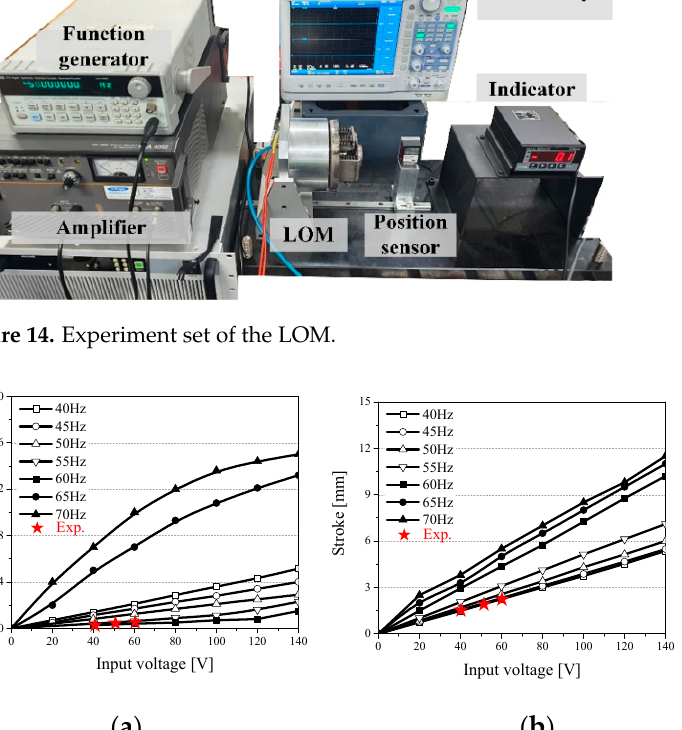
Figure 15. Transient analysis results of the LOM: ( a ) current and ( b ) stroke.